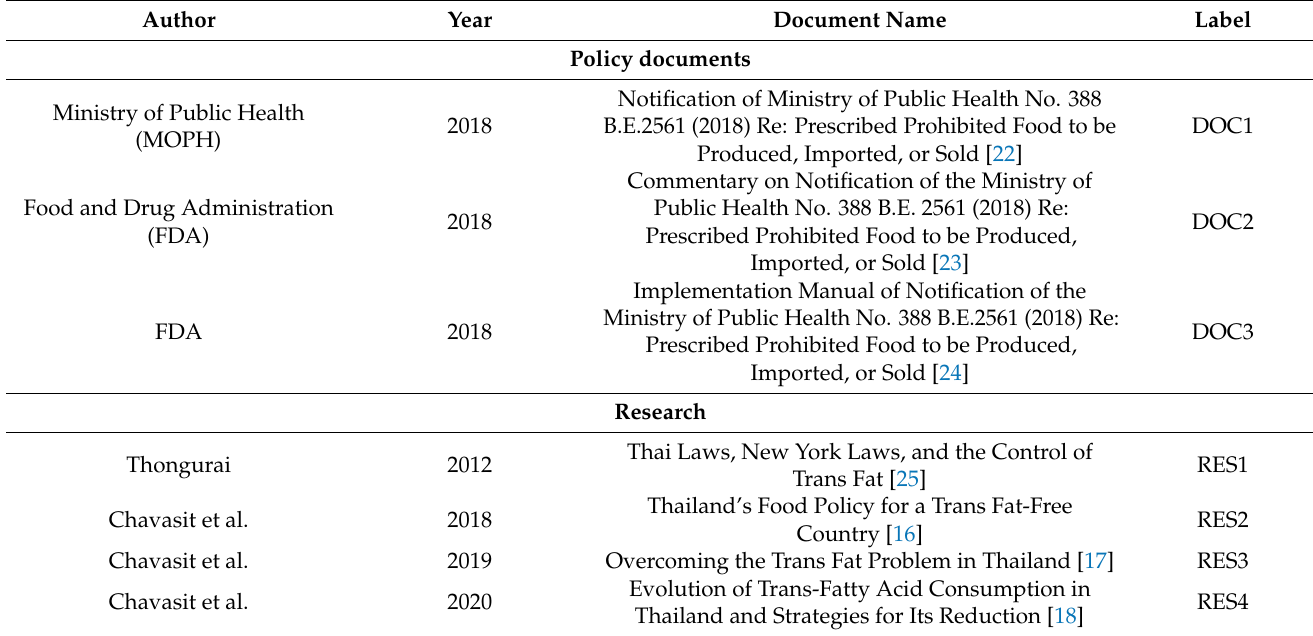
Table 2. Description of documents in an analysis of the PHO ban in